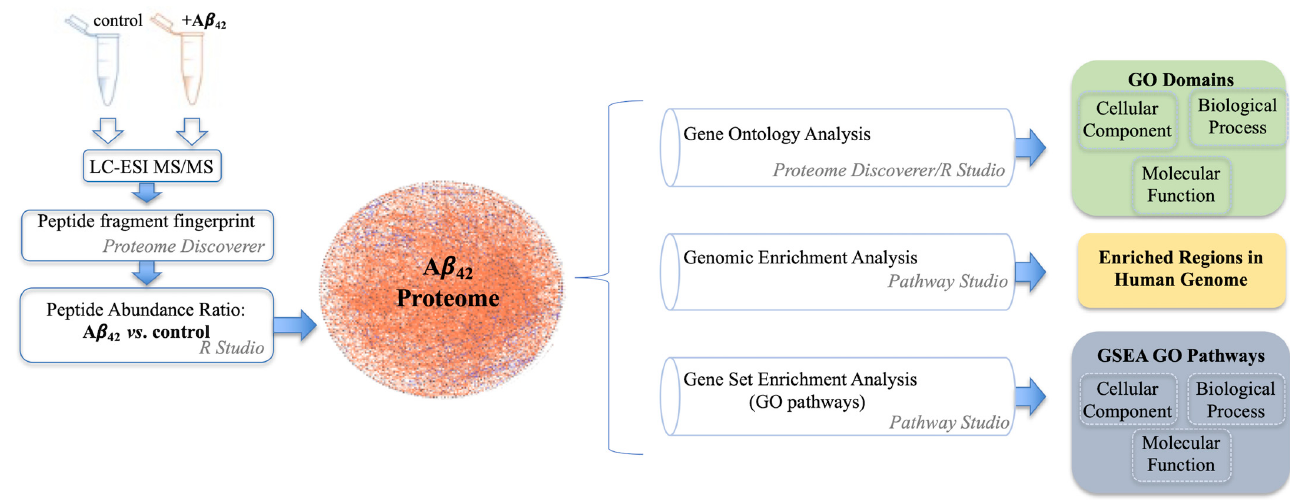
Figure 1. A flowchart summary of the mass spectrometry and bioinformatic analysis approach.